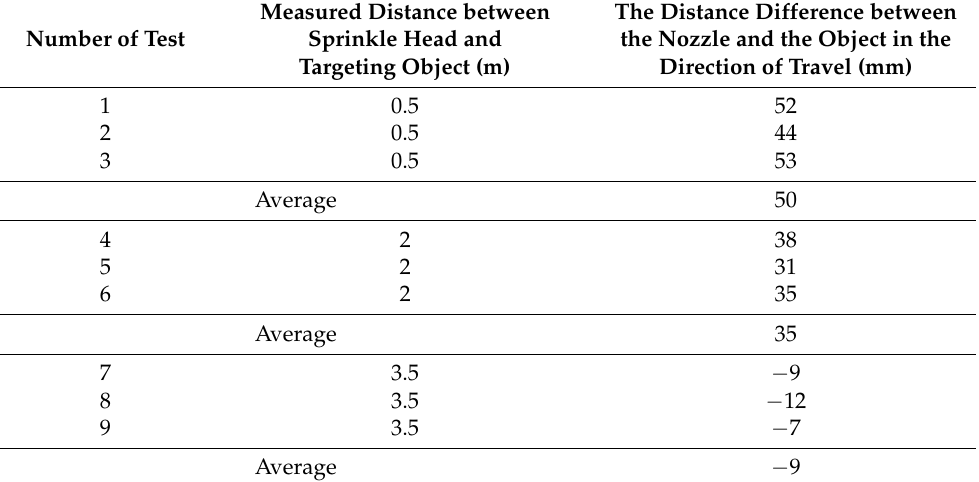
Table 8. The measured result of the targeting effect. When the distance difference between the sprinkler head and the targeting object in the direction of travel is positive, it means that the solenoid valve is opened in advance, and the sprinkler head does not go to the specified position. When the distance difference is negative, the solenoid valve is delayed opening, and the nozzle has exceeded the specified